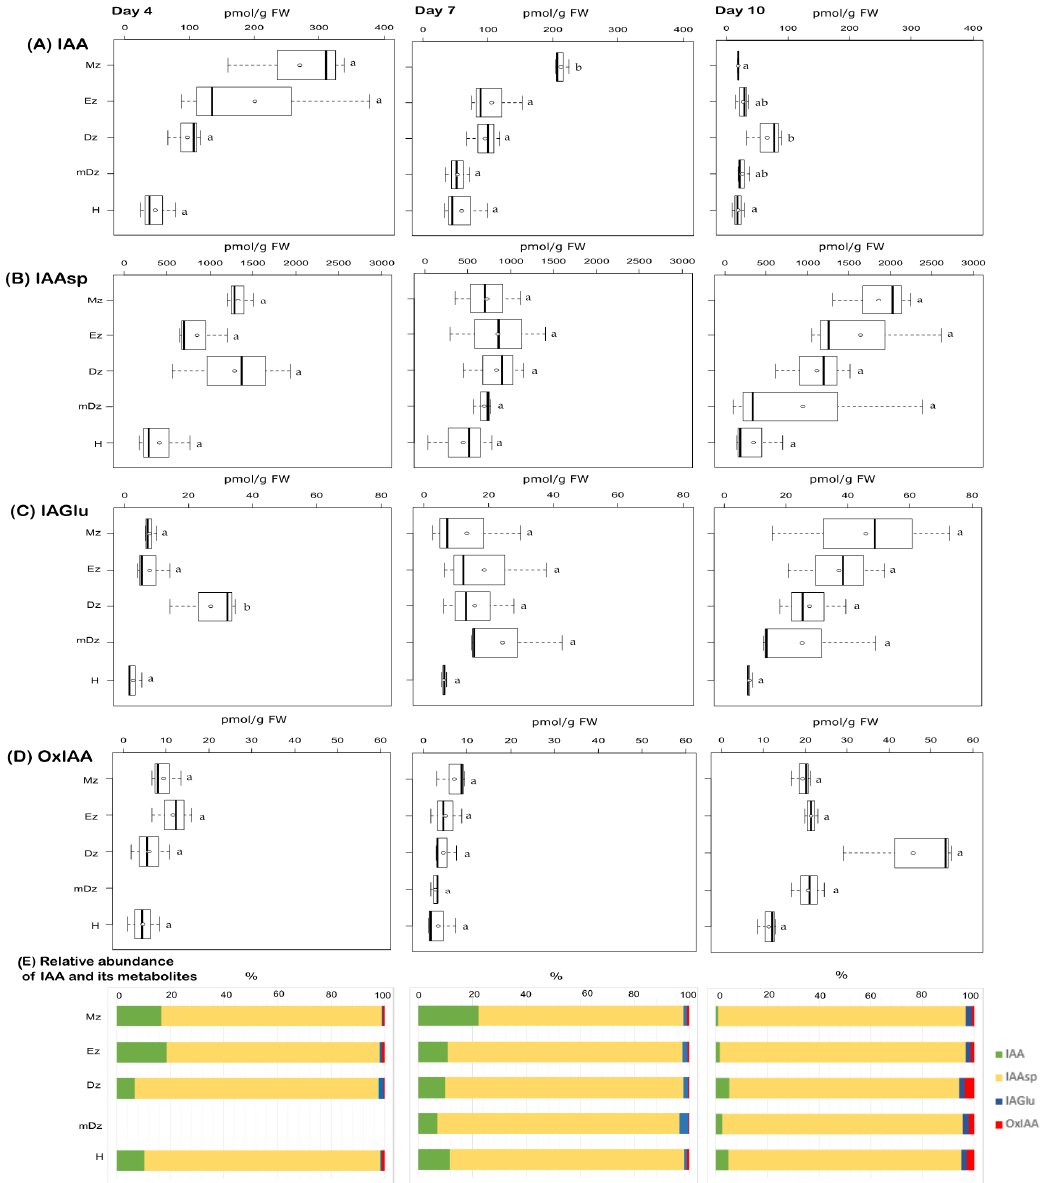
Figure 2. Quantification of auxin metabolites in hypocotyl and developmental root sections of cacao seedlings. Levels of ( A ) indole-3-acetic acid (IAA), ( B ) indole-3-acetyl-L-aspartic acid (IAAsp), ( C ) indole-3-acetyl-L-glutamic acid (IAGlu), and ( D ) 2-oxindole-3-acetic acid (oxIAA) were determined from the samples described in Figure 1. The dark vertical line indicates median; boxes represent 25th and 75th percentiles; horizontal linesrepresentmaximum and minimum values; circlesindicate mean values. Significant variations in concentration determined by Welch’s test post hoc, p ≤ 0.05 among hypocotyl and primary root sections are indicated by letters, n = 3 independent biological replicates; FW = fresh weight. ( E ) Percent proportion of each auxin